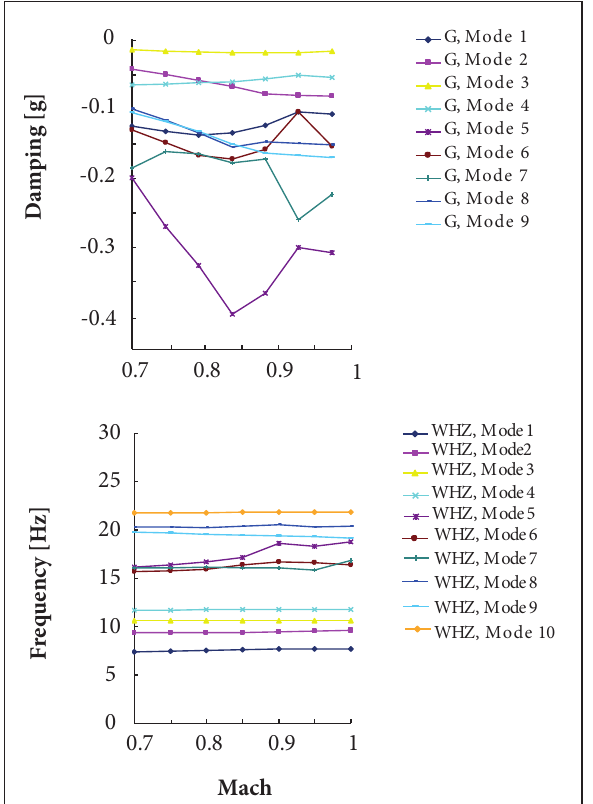
Figure 8. Coupling mechanisms for the aircraft, reference Mach